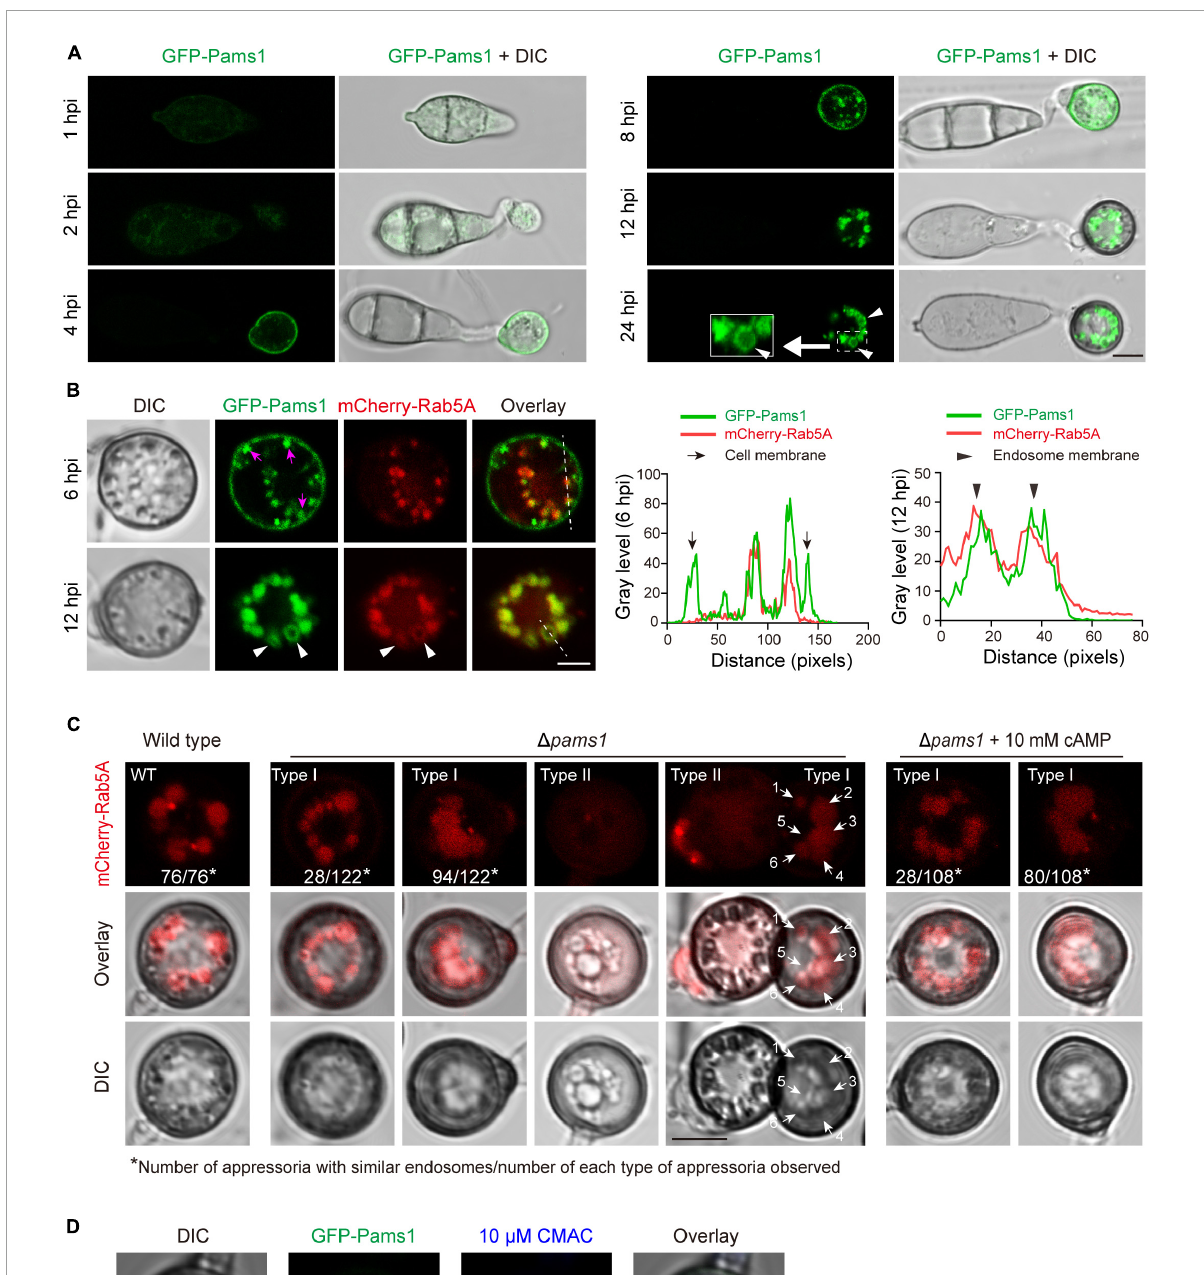
FIGURE10 Pams1 is required for the morphology and distribution pattern of endosomes in appressoria. (A) Localization of GFP-Pams1 in spores and developing appressoria at 1–24 hpi. The strain is the complementation strain of (cid:49) pams1 constructed by introducing GFP-PAMS1 . (B) Left, co-localization of GFP-Pams1 and the endosome marker mCherry-Rab5A in appressoria at 6 and 12 hpi. Right, line-scan graphs showing GFP-Pams1 and mCherry-Rab5A fluorescence density in transverse sections of several endosomes. Pams1 and Rab5A are co-localized in the endosomal membrane. Magenta arrowheads indicate vesicles linked with the cell membrane. The strain is (cid:49) pams1 expressing both GFP-PAMS1 and mCherry-RAB5A . White triangular arrowheads indicate endosome membranes (A,B) . (C) Endosomes marked by mCherry-Rab5A in the appressoria of the wild type and (cid:49) pams1 at 24 hpi. White arrows with numbers refer to six endosomes. (D) Endosomes or endolysosomes were stained by 10 µ M CMAC in appressoria of the complementation strain of (cid:49) pams1 constructed by introducing GFP-PAMS1 . Spore suspensions were added with CMAC solution (final concentration 10 µ M), inoculated on hydrophobic borosilicate glass coverslips, and cultured for 24 hpi. Scale bars, 5 µ